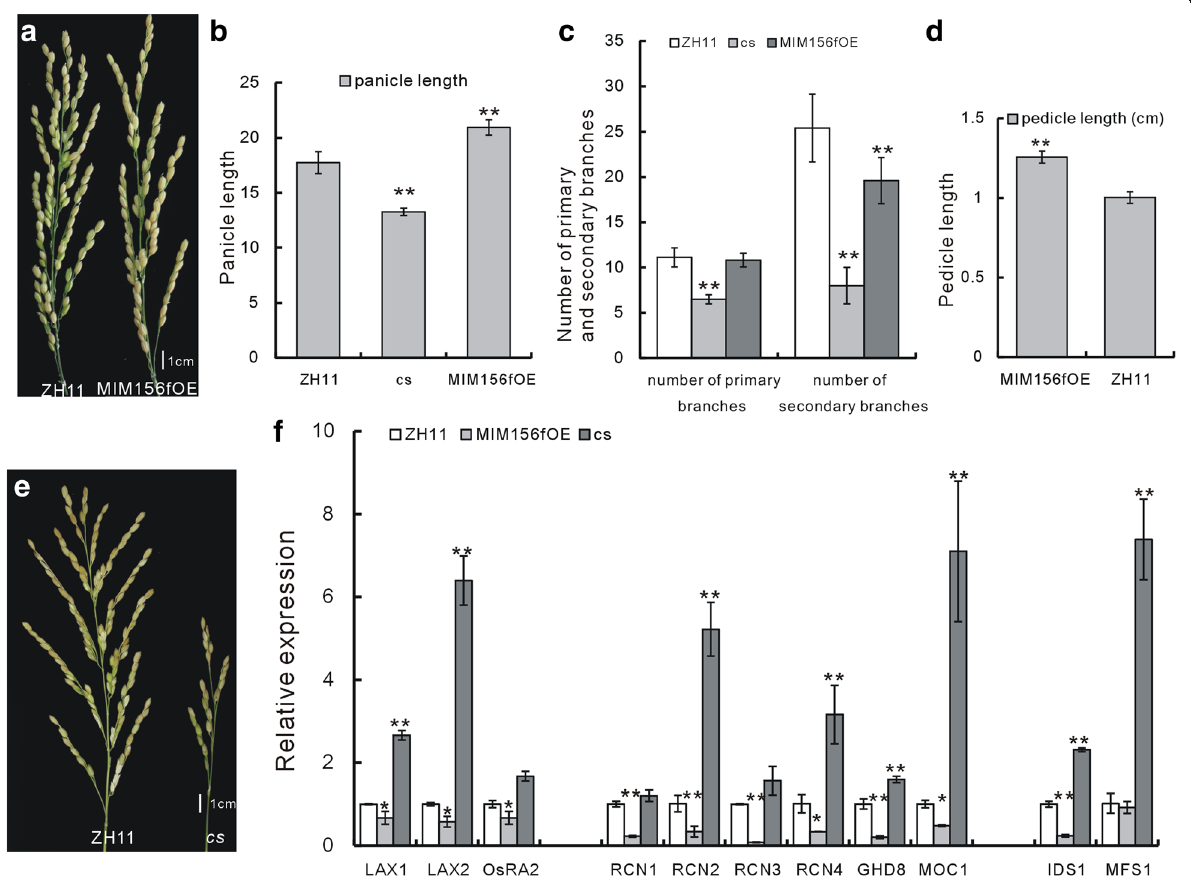
Fig. 1 Panicle characters of the miR156f-related plants and expression analysis of some panicle related genes. a Overall morphology of the panicles of the MIM156fOE and the WT ZH11 plants. b Statistical analysis of the panicle length of the MIM156fOE plants, the cs mutant and the WT ZH11 ( n = 30). c Statistical analysis of the number of the PBs and SBs of the MIM156fOE plants, the cs mutant and the WT ZH11 ( n = 20). d Statistical analysis of the pedicel length of the MIM156fOE plants and the WT ZH11 ( n = 20). e Overall morphology of the panicles of the cs mutant and the WT ZH11. f Expression analysis of some panicle development related genes in the MIM156fOE plants, the cs mutant and the WT ZH11 by qRT-PCR ( n = 3), young panicles of 2 cm long were used for detection. Single and double asterisks represent significant difference determined by the Student ’ s t -test at * P < 0.05 and ** P <